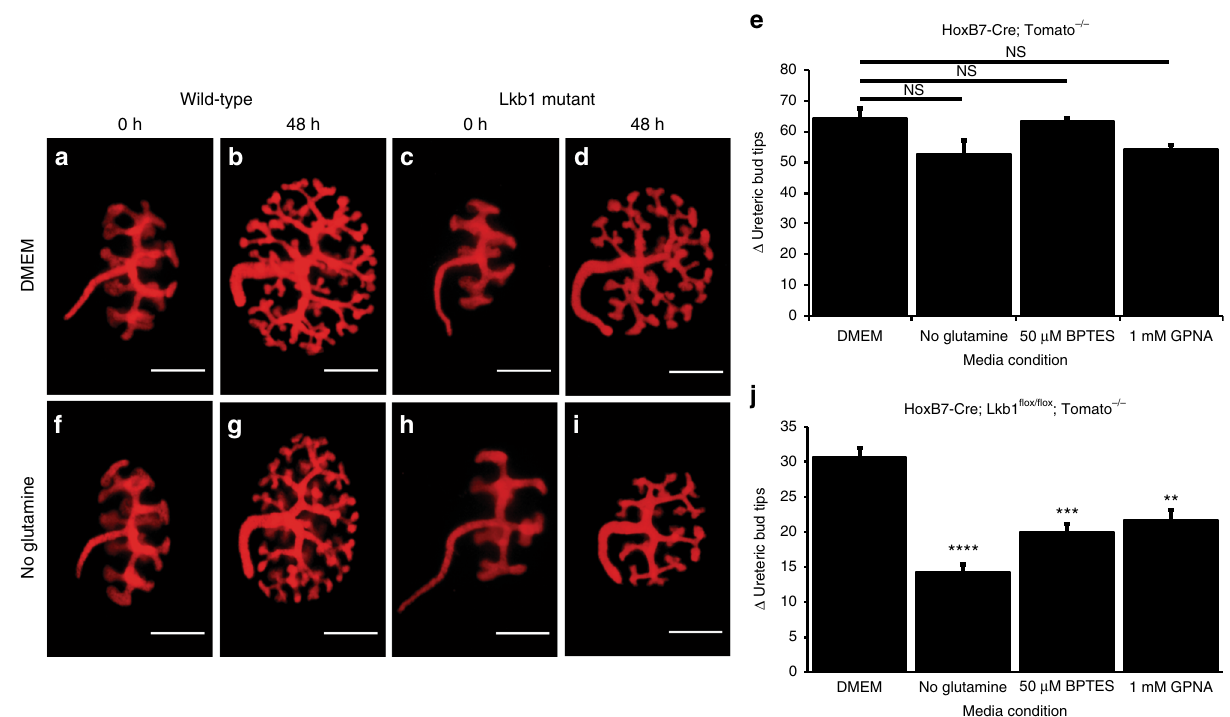
Fig. 2 Perturbation of glutamine metabolism causes growth defect in embryonic Lkb1 mutant collecting ducts. Live images of E12.5 HoxB7-Cre; RosaTomato ( n = 10) ( a , b , f , g ) and HoxB7-Cre; Lkb1 fl ox/ fl ox ; RosaTomato ( n = 10) ( c, d, h, i ) kidneys after 0 ( a , f , c , h ) or 48 ( b , g , d , i ) hours of culture in control media (DMEM, a − d ) or DMEM lacking glutamine ( f – i ). Quanti fi cation of the change ( Δ ) in branch number (number of ureteric bud tips after 48 h — ureteric bud tips at 0 h) for HoxB7-Cre; RosaTomato ( e ) or HoxB7-Cre; Lkb1 fl ox/ fl ox ; RosaTomato ( j ) kidneys grown in complete DMEM, DMEM-glutamine, DMEM+ 50 µ M concentration of the glutaminase inhibitor BPTES, or 1 mM concentration of the Slc1a5 glutamine transporter inhibitor GPNA. n = 10 for each genotype under each condition. Statistical analysis via Mann − Whitney U -test ** p < 0.01, *** p < 0.001, **** p < 0.0001, NS not signi fi cant. Error bars shown as mean ± standard error of the mean (SEM). Scale bars equal 30